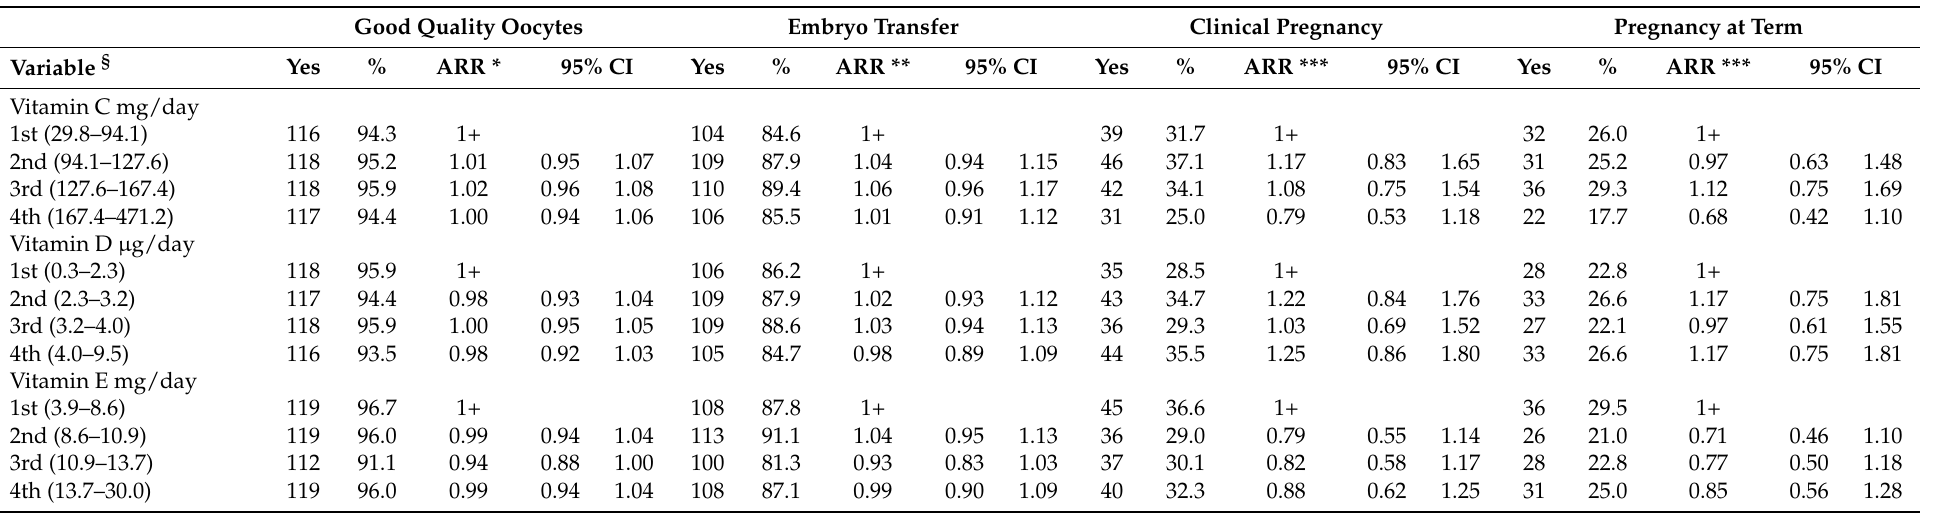
Table 3. Adjusted relative risks (ARR) and 95% confidence intervals (CI) for percentiles of selected food